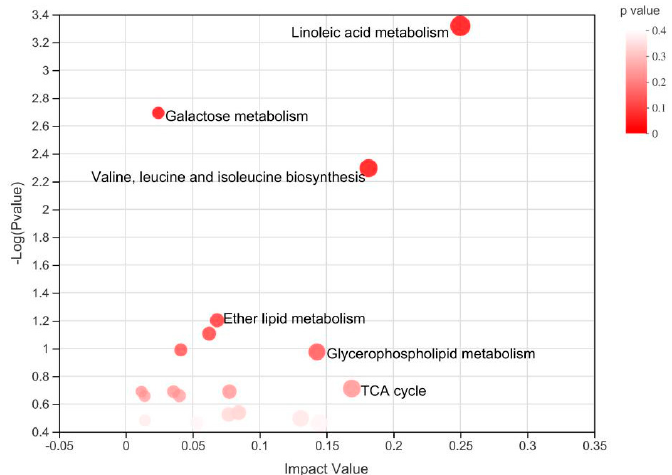
Figure 4. Metabolome map of common metabolites identified in plasma. The x -axis represents the pathway impact, and the y -axis represents the pathway enrichment.